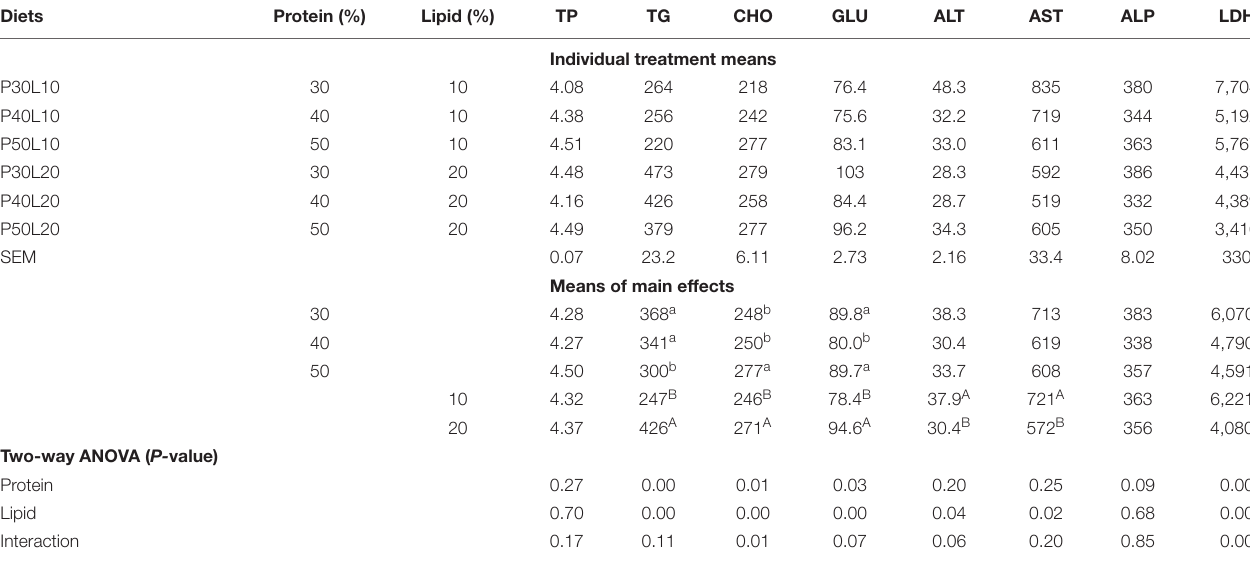
Two-way ANOVA ( P- value) Protein 0.27 Lipid Interaction